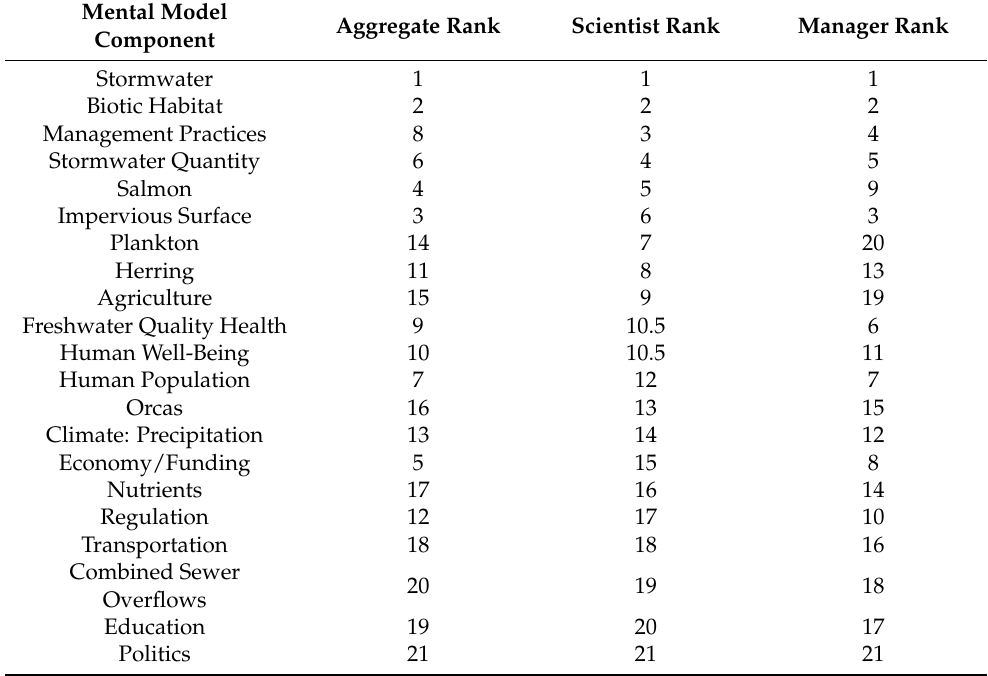
Figure 5. Spearman rank order correlation reveals a positive correlation between centrality of components in an aggregate model derived from stormwater managers and an aggregated model derived from stormwater scientists. Table 2. Rank centrality scores for components in the mental model created by aggregating all stormwater experts (aggregate model); a model derived by aggregating models from stormwater scientists (scientist rank), and a model derived by aggregating models from stormwater managers (manager rank). Centrality rank is the overall influence in a model, with rank one being the most important and 21 being the least important.